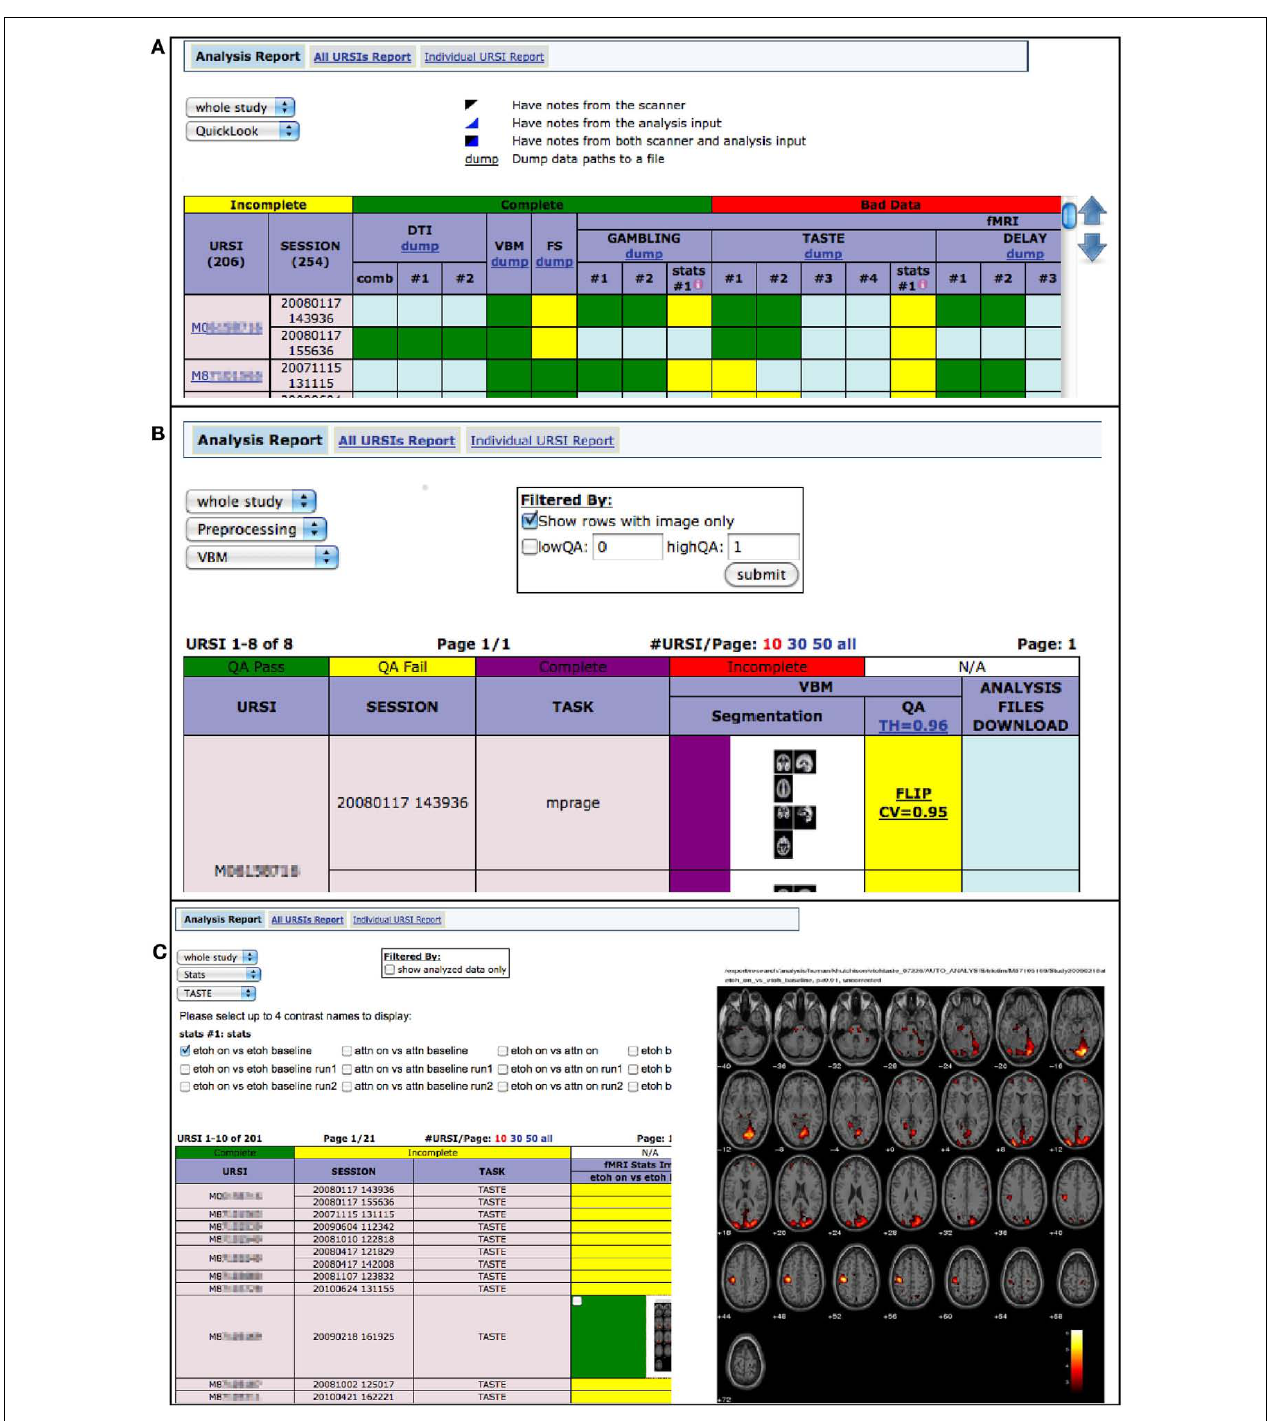
status is viewable and associated files may be downloaded (option available behind zoomed image) (C) investigators may view fMRI statistics, on each task, for various